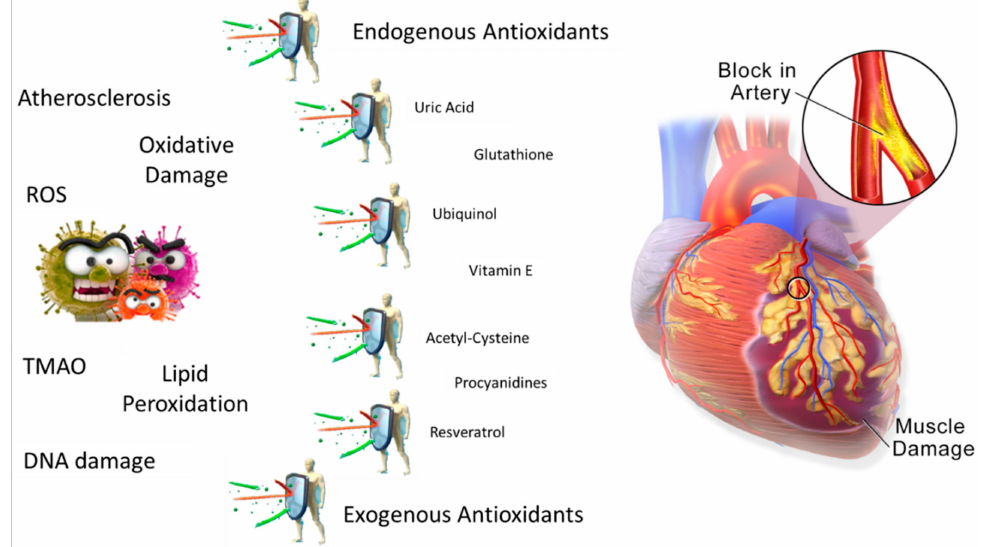
Figure 1. Schematic representation of the antioxidant mechanism of action pursued to avoid cardiovascular disease (CVD) onset. If the antioxidant system is unable to scavenge a high amount of reactive oxygen species (ROS), foods or nutraceuticals with proven antioxidant capacity should be